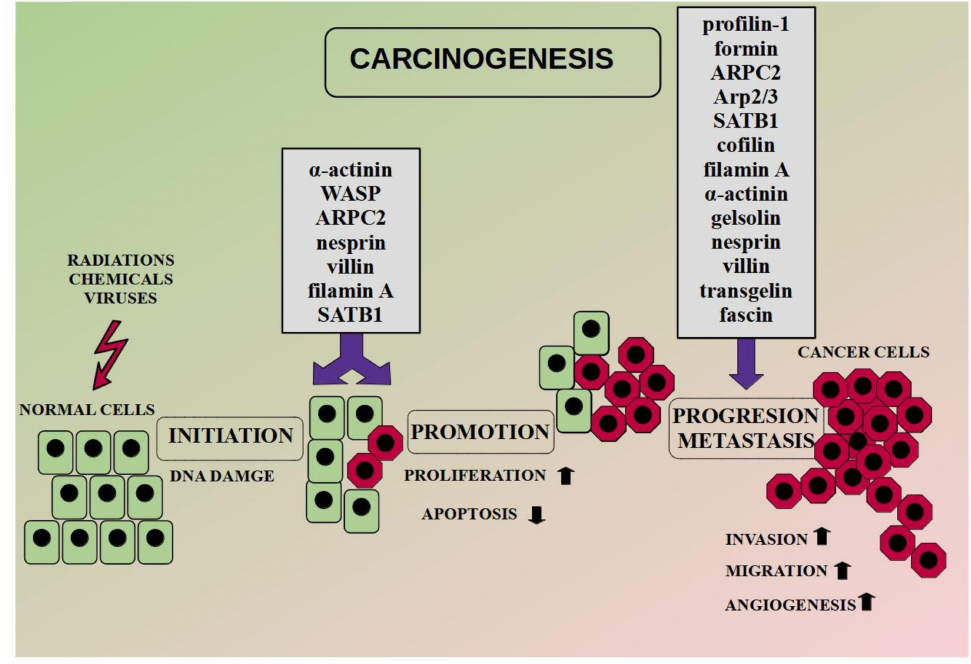
Figure 2. ABPs in carcinogenesis. Modified on the basis of Burgio and Migliore (2015) [98]. 4. The Involvement of Actin and ABPs in Cancer Progression (EMT and